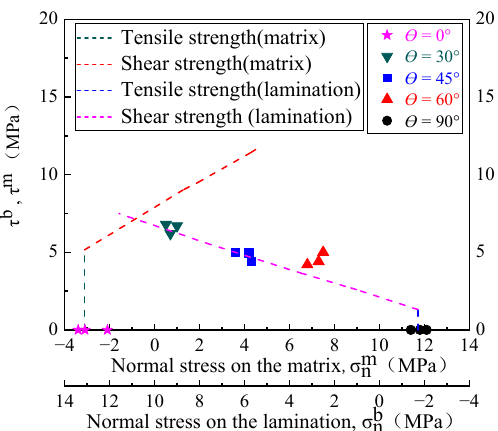
Figure 10. The relationship between stress and strength at different layer orientations. It can be seen from Figure 10 that when θ = 90°, σ n = σ t and τ = 0 can be calculated from Formulas (5) and (6), respectively, indicating that there is no shear stress on the lamination, and the sample will not undergo shear failure along the lamination. The tensile stress at the center of the sample was calculated to be 4.54 MPa, which was larger than the tensile strength of the lamination (Formula (7)). Therefore, tensile failure occurred along the lamination. When θ = 0°, there is also only normal stress but no shear stress on the lamination. The calculated tensile stress at the center of the sample is 6.29 MPa, which is larger than the tensile strength of the matrix (Formula (8)), so the matrix suffers tensile failure. Due to the different degrees of defects distributed on the lamination surface of continental shale, fractures spread along the defects after communicating with the lamination surface. Therefore, it was observed in the test that fractures spread along the lamination for a short distance and then spread through the lamination. When θ = 30°, 45°,